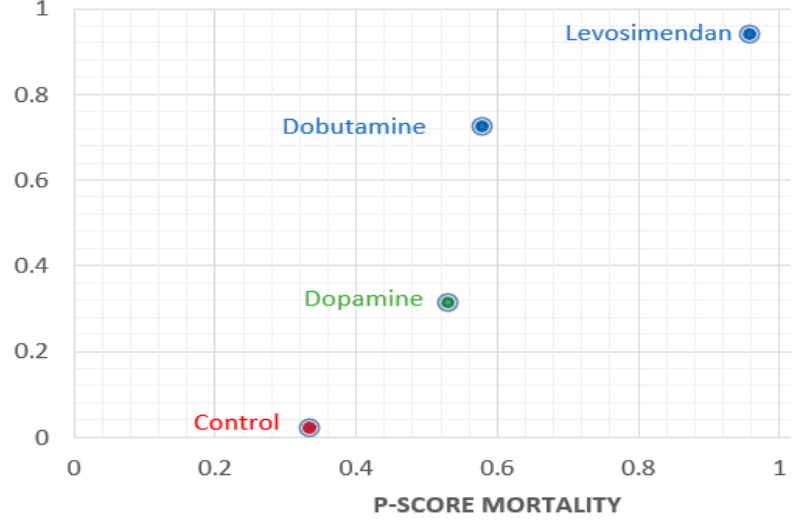
Figure 3. P-scores ranking plot. The X axis represents the P-score of mortality and the Y axis represents the P-score of the glomerular filtration rate (GFR). The higher P-score corresponds to better results. Therefore, the dot in the upper right corner of the chart indicates a better treatment effect.